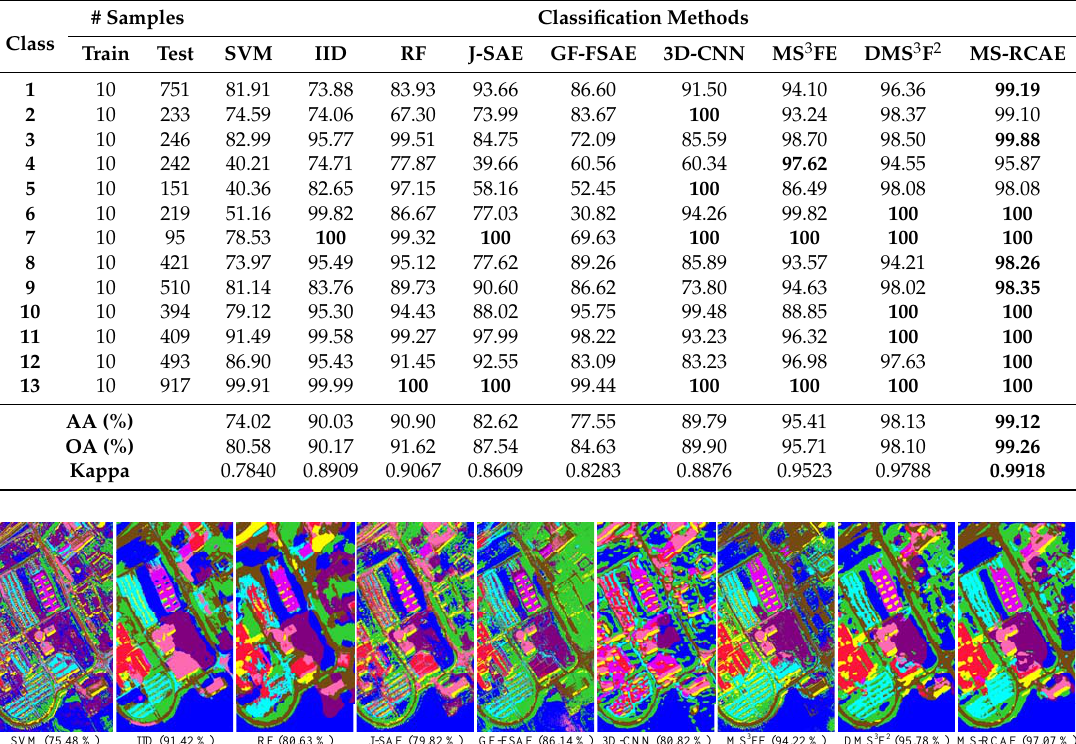
Figure 10. Classification maps of the University of Pavia dataset obtained by different methods